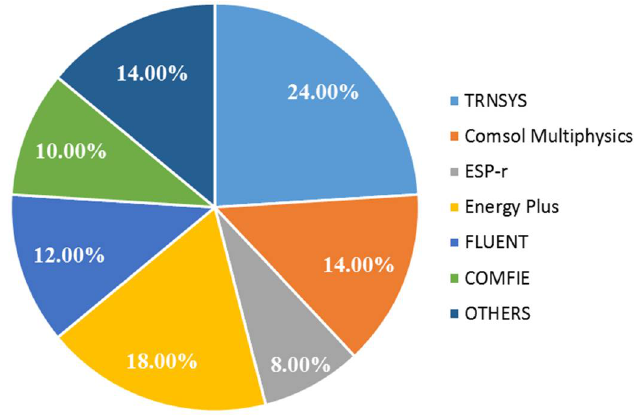
Figure 14. Analysis and simulation tools per their usage in the analyzed research papers.